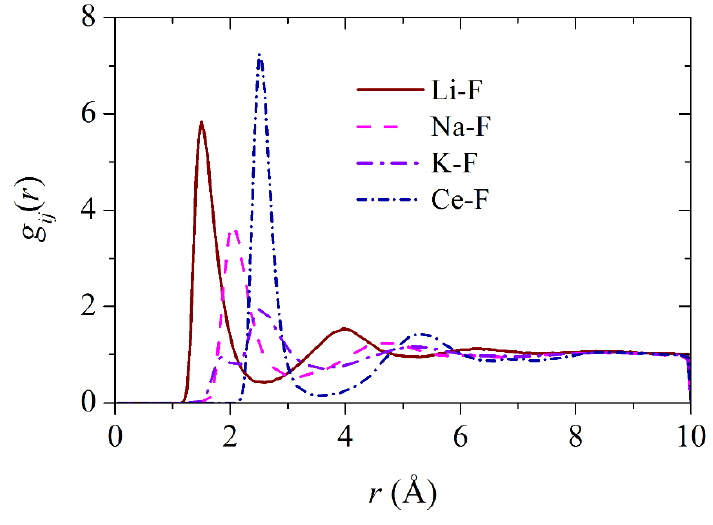
Figure 6. The partial radial distribution functions of Li–F, Na–F, K–F and Ce–F at 950 K. The cation–cation and anion–anion radial distribution functions for the FLiNaK+15